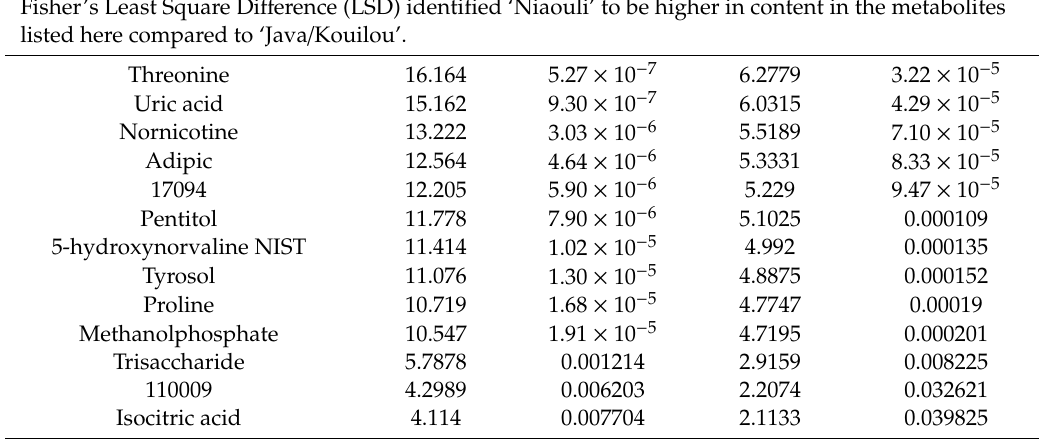
Metabolomic Markers f . Value p . Value − Log10(p)